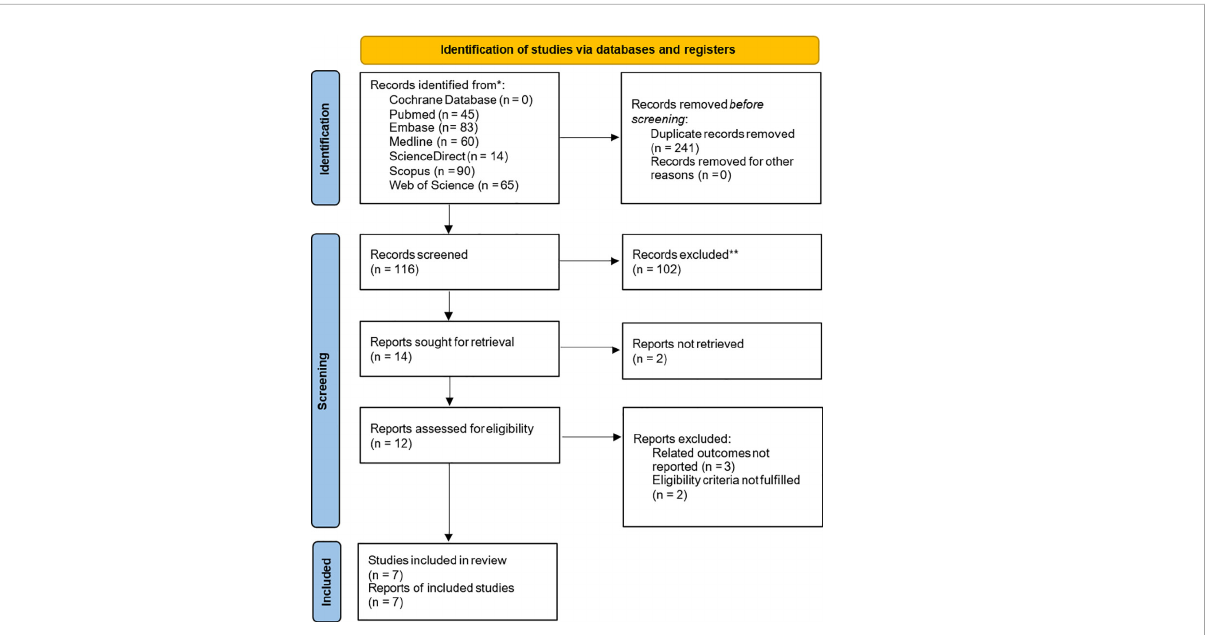
FIGURE 1 Flowchart of literature search and study selection. Flowchart of literature search and study selection. *Consider, if feasible to do so, reporting the number of records identi fi ed from each database or register searched (rather than the total number across all databases/registers). **If automation tools were used, indicate how many records were excluded by a human and how many were excluded by automation